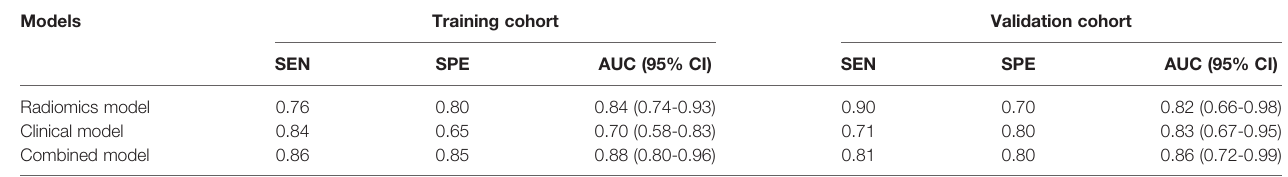
SEN, sensitivity; SPE, speci fi city; AUC, are under curve; 95% CI, 95% con fi dence interval.